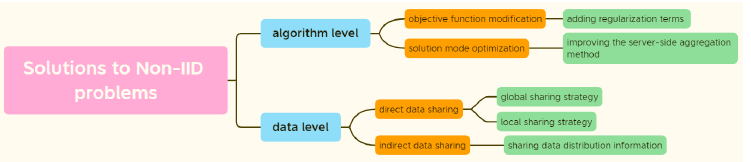
Figure 1. Solutions to non-IID